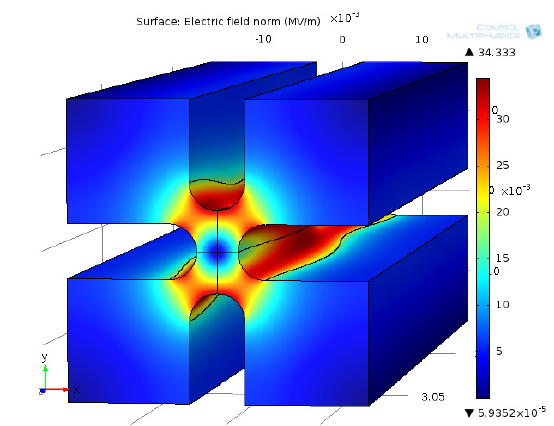
Figure 5. Surface electric field in an electrostatics model of three cells computed to extract the maximum surface field per cell. Only the vane region is considered for the calculation.